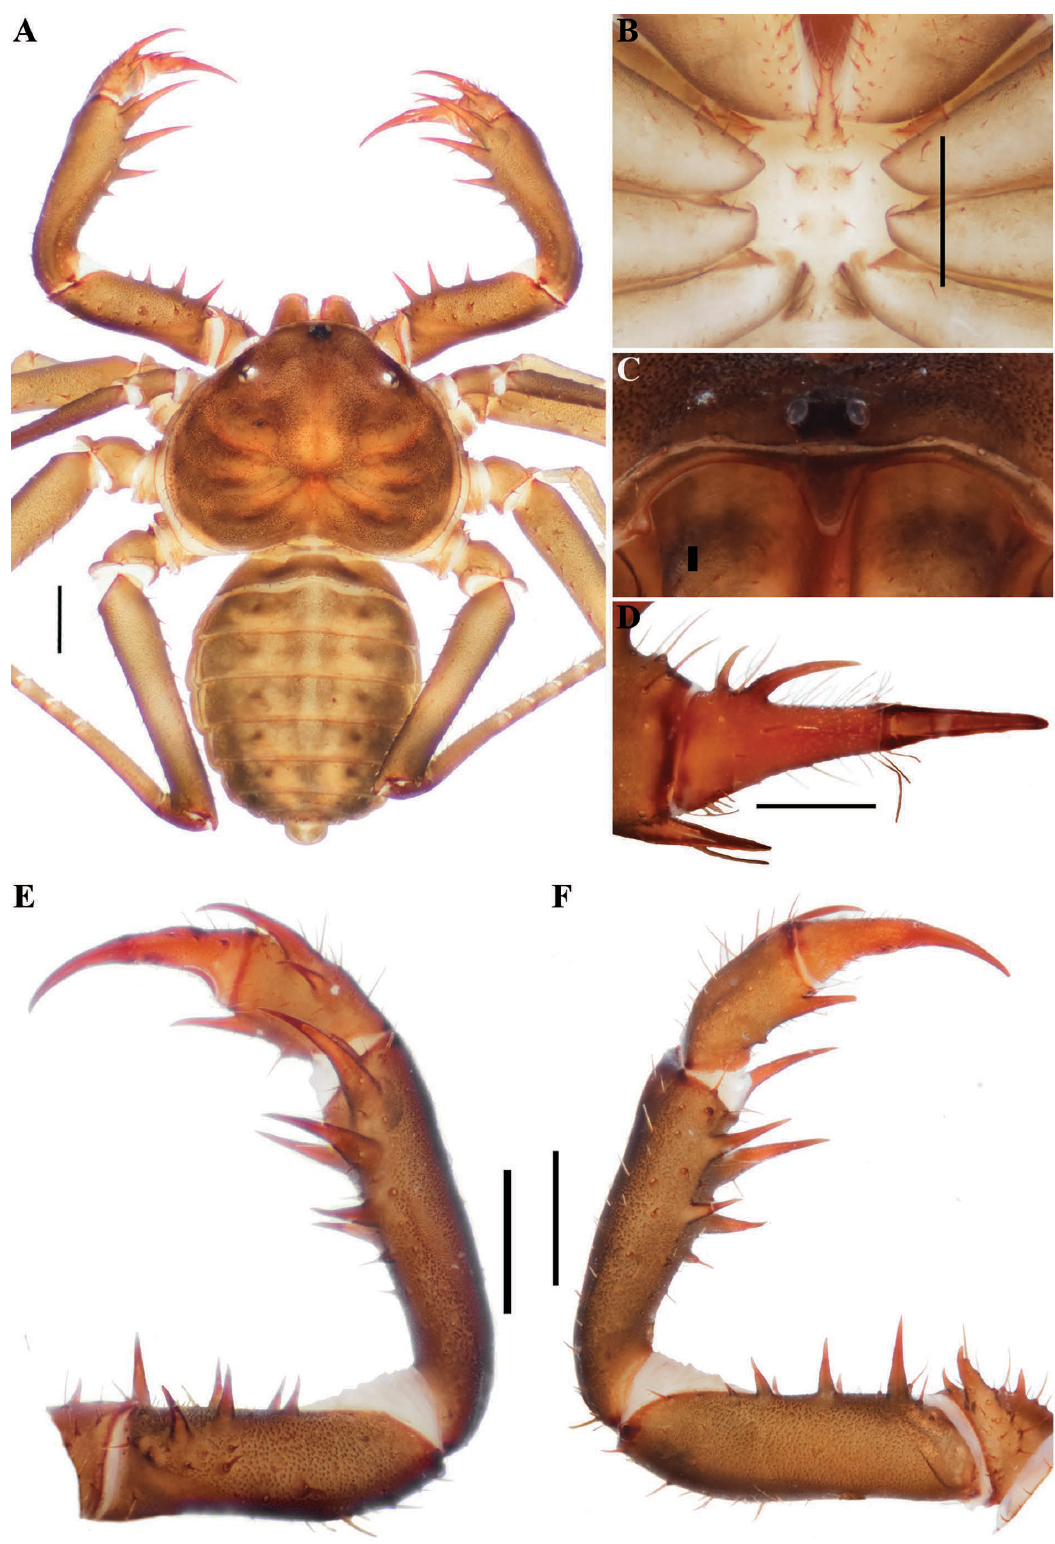
Fig. 101. Charinus pescotti Dunn, 1949 (AMCC [LP 6367]), general morphology, ♂ . A . Habitus, dorsal view. B . Sternum, ventral view. C . Frontal process. D . Pedipalp tarsus, frontal view. E . Pedipalp, dorsal view. F . Pedipalp, ventral view. Scale bars: A–B, E–F = 1 mm; C = 0.1 mm; D =